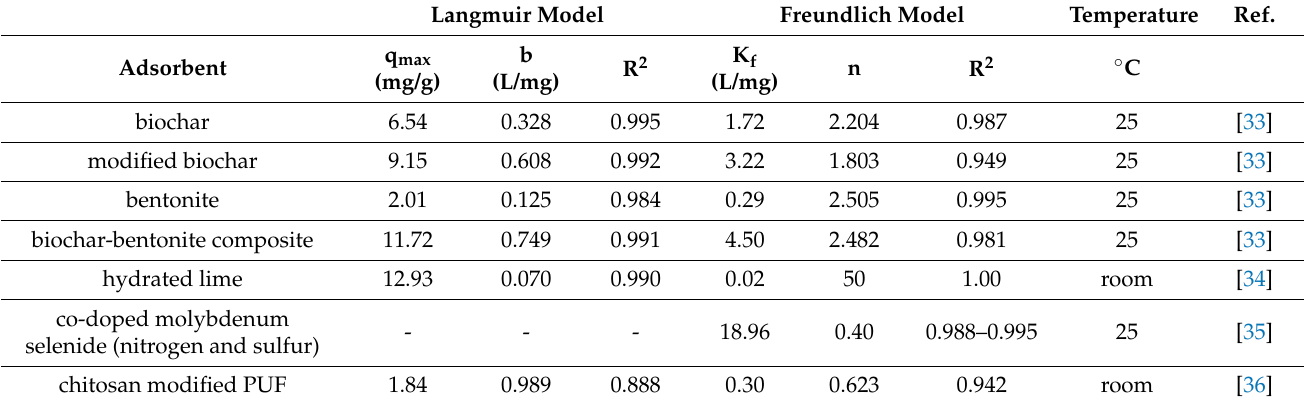
Table 6. Performances of some non-commercial adsorbents tested for the removal of mercury. Langmuir Model